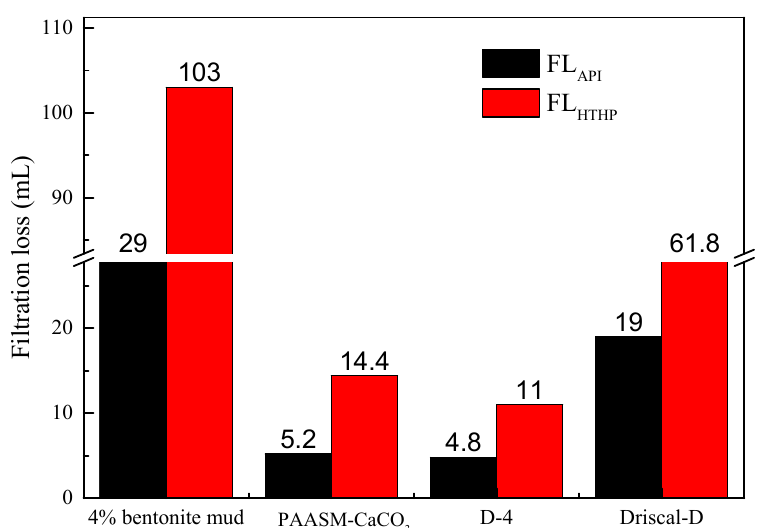
Figure 9. Filtration loss in based muds after aging at 200 °C.